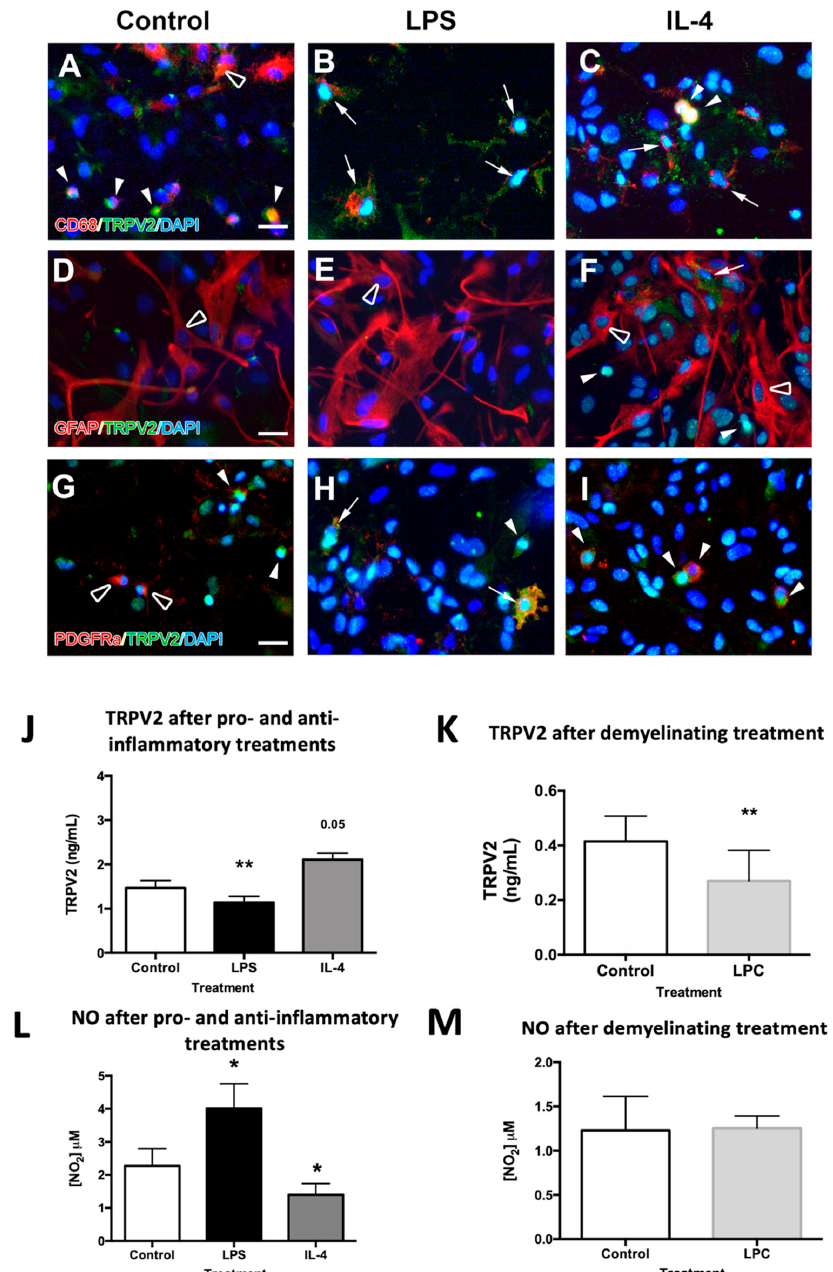
Figure 2. TRPV2 expression in mixed glia cultures of mice after pro-inflammatory (LPS), anti- inflammatory (IL-4) and demyelinating (LPC) treatments. ( A – I ) Double immunohistochemical staining allowed for the determination of whether TRPV2 was expressed in microglia ( A – C ), astrocytes ( D – F ) or oligodendrocyte cells ( G – I ). TRPV2 was highly expressed in the cell body of some microglia (full arrowheads) but not all of them (empty arrowheads) in control conditions, and TRPV2 was spread afterwards through the cell body of activated microglia cells, with an expression pattern highly coincident with CD68+ lysosomes (arrows). While no expression of TRPV2 was found in astrocytes (empty arrowheads), OPCs showed either low or absent expression in control conditions (full and empty arrowheads, respectively) and increased expression throughout the cell body